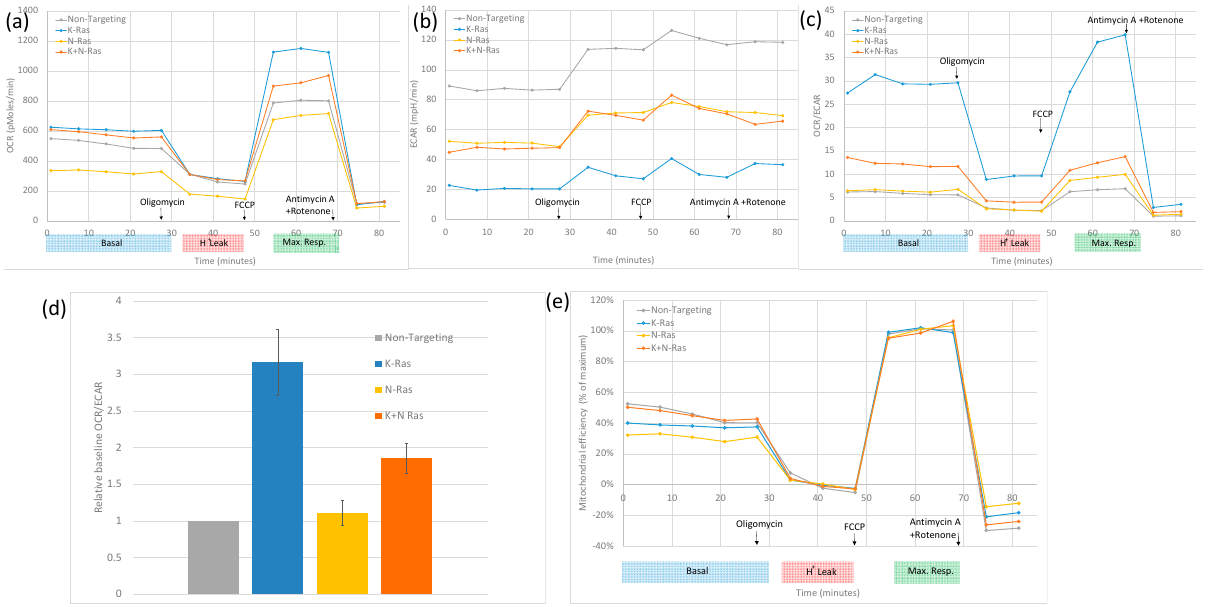
Figure 6. Effects of K-Ras and N-Ras depletion on oxidative phosphorylation: ( a ) Representative Sea Horse analysis showing oxygen consumption rate (OCR) measured over time with the treatments shown. Oligomycin reduced oxygen consumption to just that due to proton leak, while FCCP uncoupled mitochondria resulting in maximal oxygen consumption. K-Ras knockdown caused an increase in uncoupled oxygen consumption while the N-Ras knockdown caused a reduction in maximal and basal oxygen consumption as well as a decrease in proton leak from mitochondria. Knockdown of N-Ras with K-Ras restores basal oxygen consumption with a smaller increase in maximal oxygen consumption and no reduction in proton leak. ( b ) The same experiment but showing Extra Cellular Acidification Rate (ECAR). K-Ras knockdown causes a reduction in ECAR, and N-Ras knockdown alone causes a smaller ECAR reduction, which is equivalent to the ECAR reduction seen when N-Ras and K-Ras are knocked down. ( c ) OCR/ECR is a measure of relative levels of respiration and glycolysis. K-Ras knockdown causes an increase in relative levels of respiration. Repeated experiments have showed this to be significantly greater than the increase seen with both K-Ras and N-Ras knockdown. N-Ras knockdown alone had little overall effect ( d ). ( e ) When OCR/ECAR is adjusted to the maximum increase in active mitochondrial activity (the difference from maximal to proton leak oxygen consumption), N-Ras knockdown was shown to reduce mitochondrial efficiency (Mann–Whitney U test, p < 0.001, standard deviation used as error bar); moreover, K-Ras knockdown had less effect on efficiency and the combination of K-Ras with N-Ras knockdown restored mitochondrial efficiency.